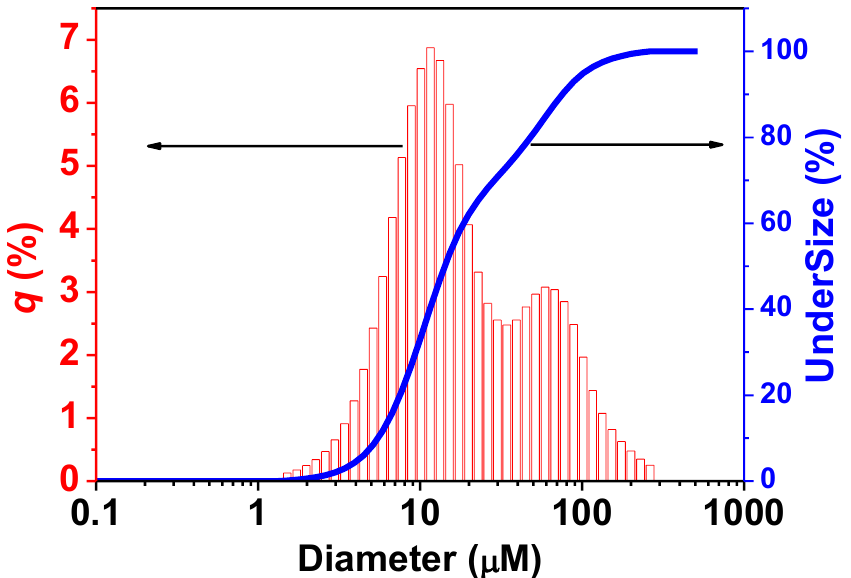
Figure 8. Results size distribution of ZnO nanorods by laser diffraction analyzer.